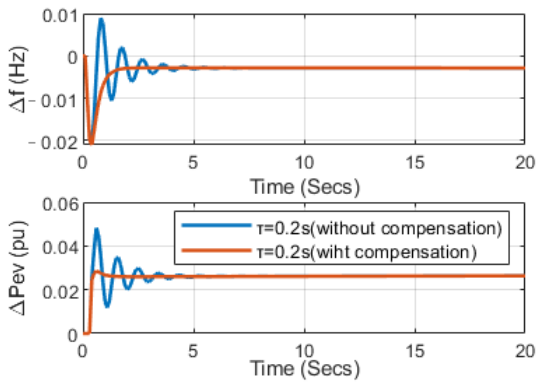
Figure 8. τ = 0.2 s system dynamic response with or without predictive compensation.